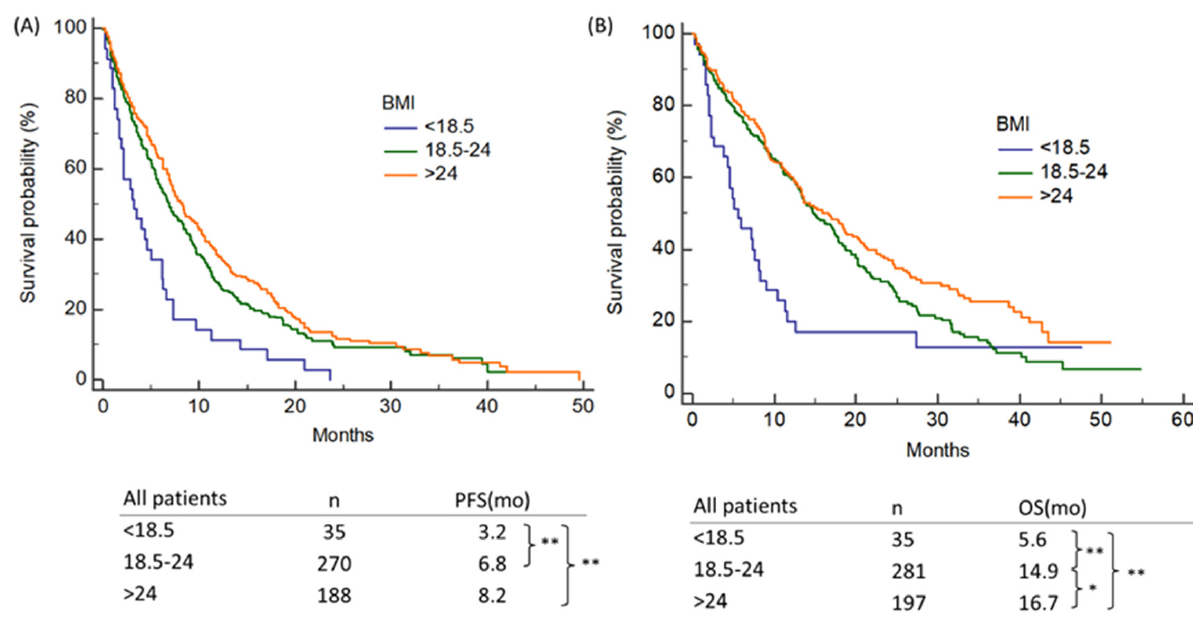
Figure 2. Influence of the baseline BMI on ( A ) PFS and ( B ) OS of NSCLC patients. BMI—body mass index; PFS—progression-free survival; OS—overall survival; NSCLC—non-small cell lung cancer; Note: * p < 0.05, ** p < 0.001.